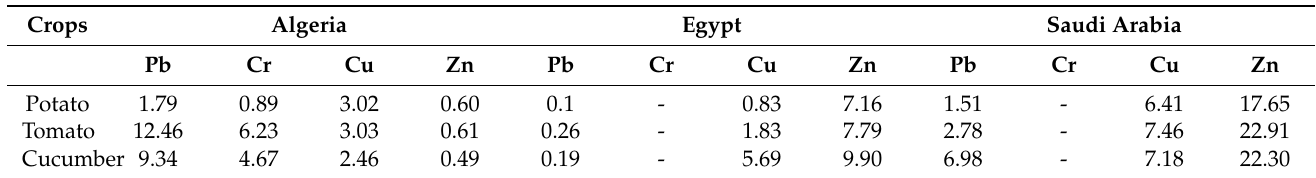
Table 10. Heavy-metal concentrations (mg/kg dry wt.) of three different vegetables grown in three countries, i.e., lead (Pb), copper (Cu), chromium (Cr), and zinc (Zn), irrigated through reclaimed water [102,132,133].